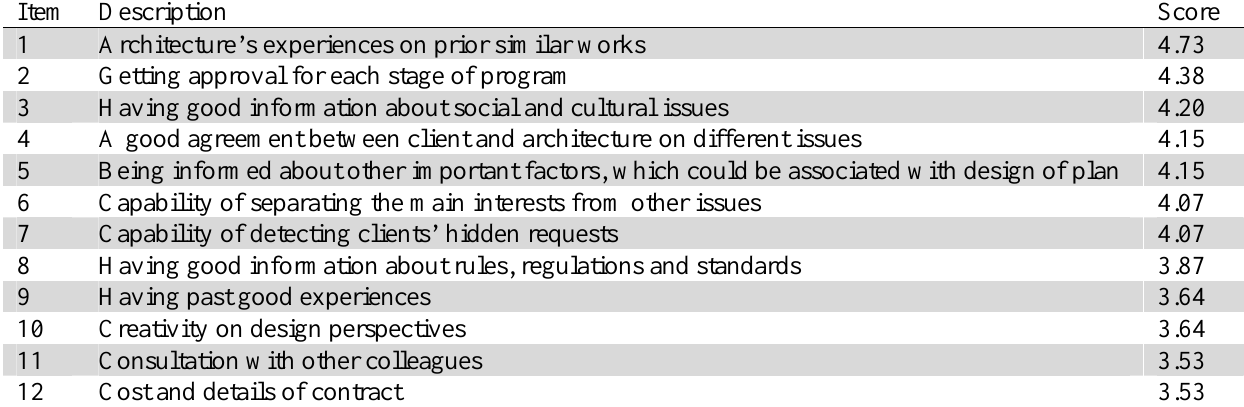
The summary of ranking various factors on how to prevent change in program